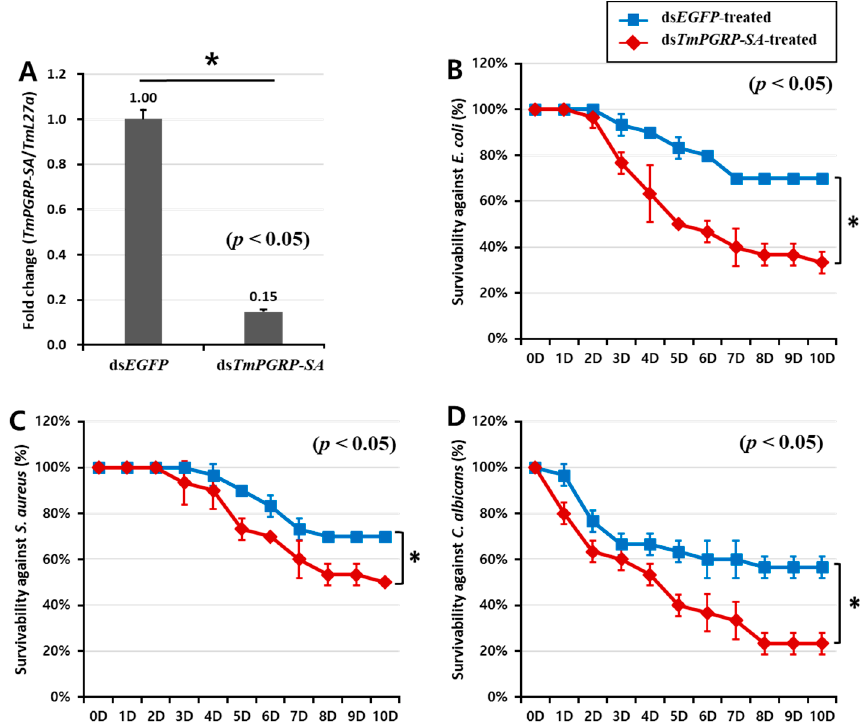
Figure 5. The pivotal role of TmPGRP-SA in the survival of T. molitor larvae following microbial infections. Knockdown efficiency of TmPGRP-SA in T. molitor larvae ( n = 3 per group) quantified by mRNA transcription after TmPGRP-SA depletion compared to ds EGFP controls carried out on the second day post-injection (80%) ( A ). Lifespan curves of ds EGFP - and ds TmPGRP-SA -injected larvae ( n = 10 per group) following immune challenge with E. coli ( B ), S. aureus ( C ), and C. albicans ( D ) over a ten-day period. Results presented are representative of three independent experiments. Asterisks depict significant differences between negative control and TmPGRP-SA -silenced larvae ( p < 0.05).